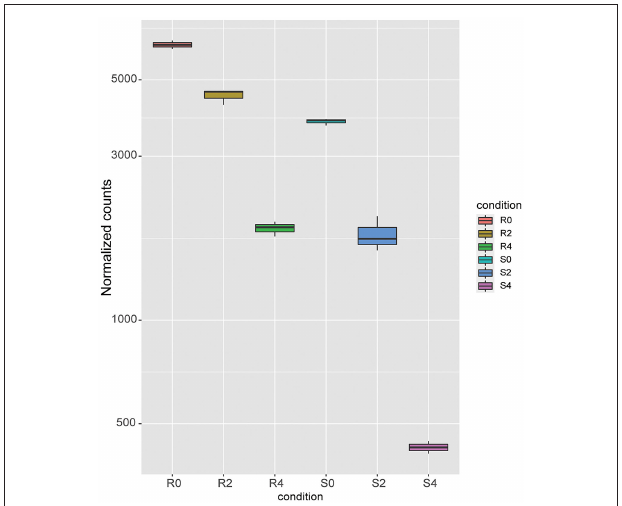
FIGURE 5 | Gene expression level of FAD-dependent monooxygenases. Boxplot was drowned out by the R package DESeq2::plotCounts using normalized read